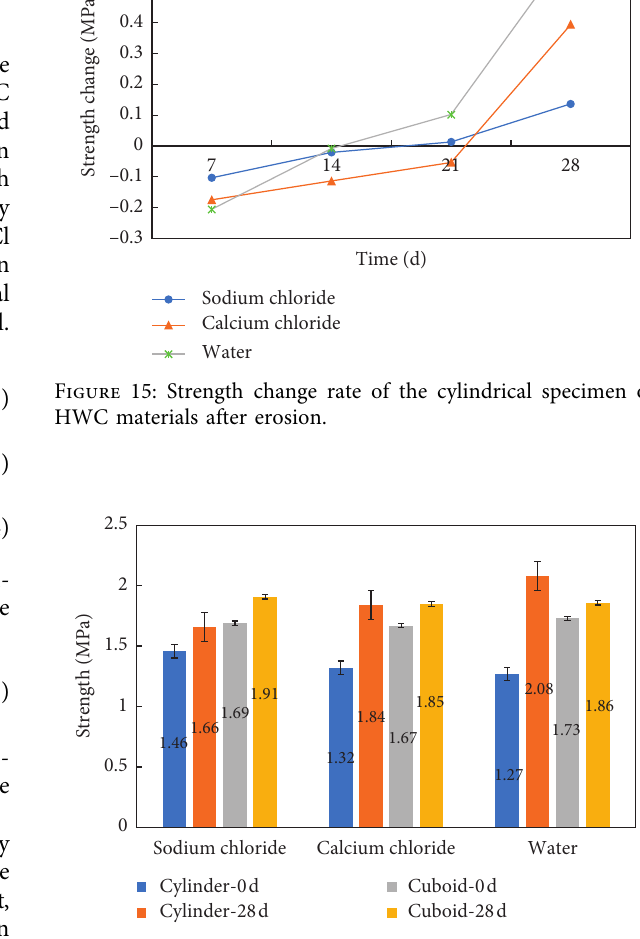
Figure 16: Strength of different specimens after 28 d of erosion by different solutions.